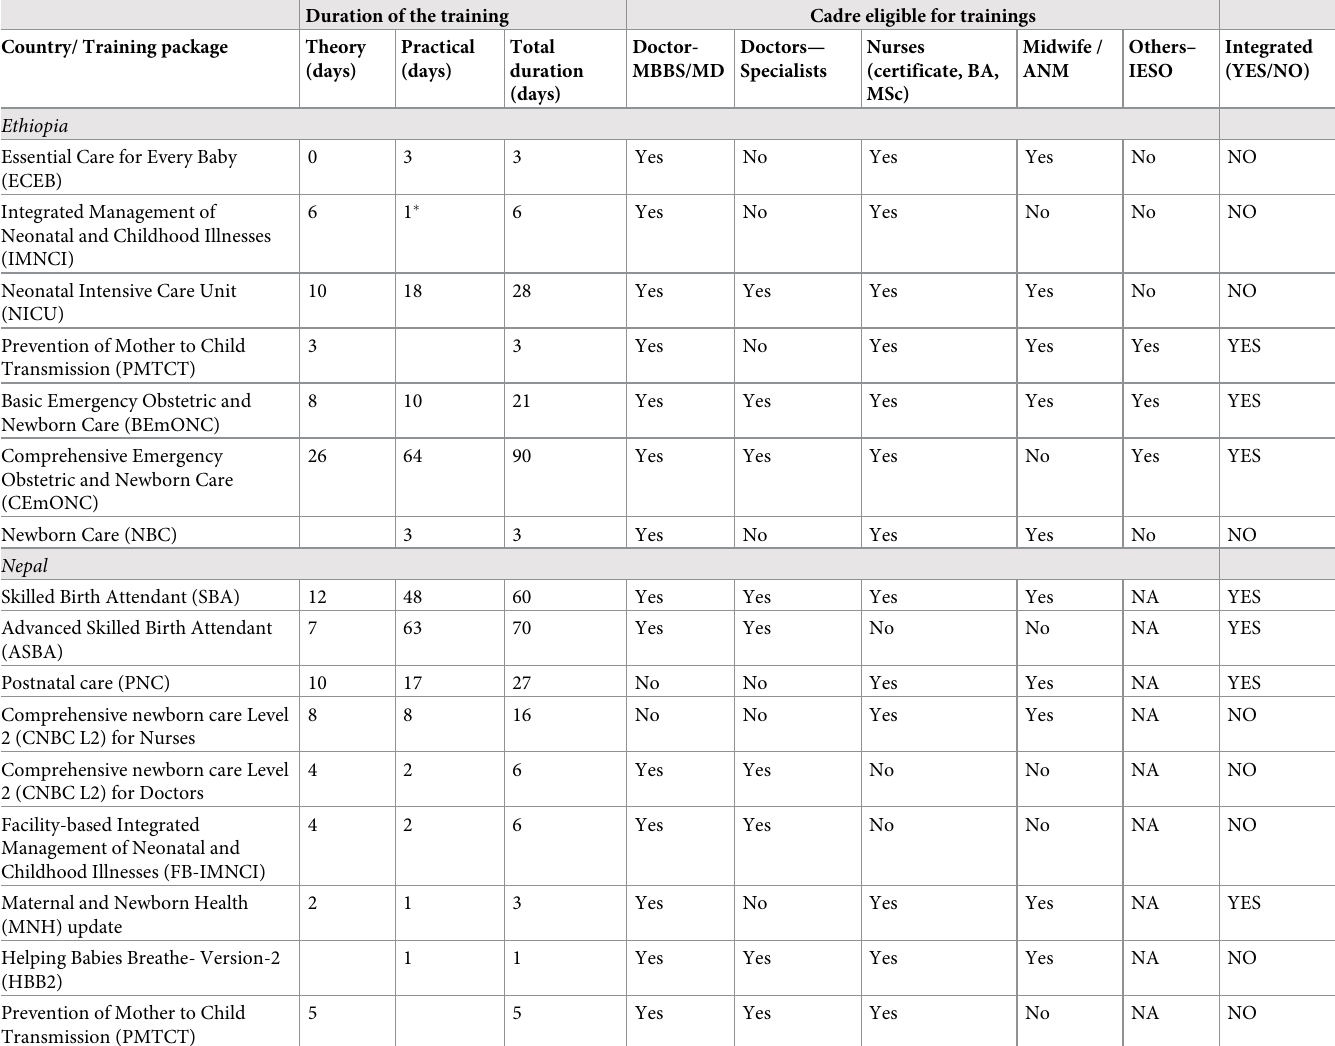
Table 2. Summary of maternal and newborn health trainings in Ethiopia and